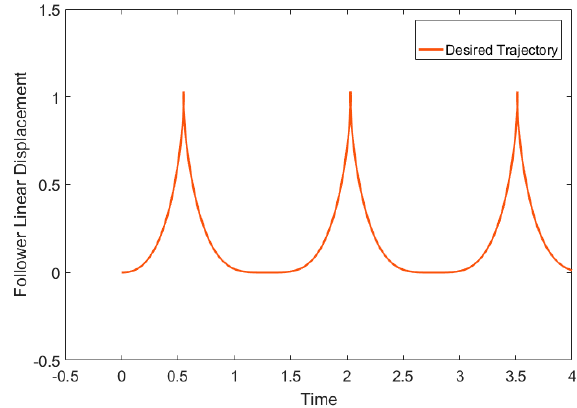
Figure 3. Desired trajectory in normalized axis.